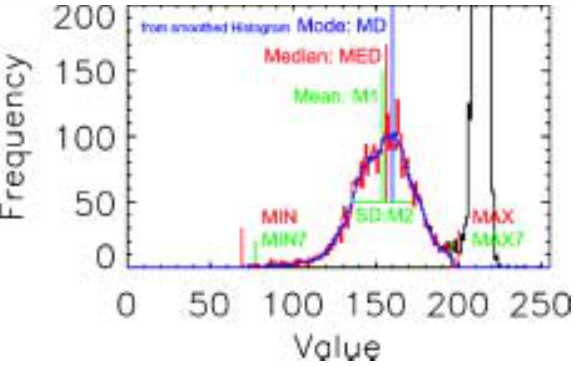
Fig. 7. Some features outlined in real histograms of transmission values (black: whole image, red: cell nucleus, blue: smoothed cell nu- cleus). Typically images have byte values with ranges of [0,255] or [ − 128,127]. This figure can be viewed on http://www.esacp.org/acp/2003/